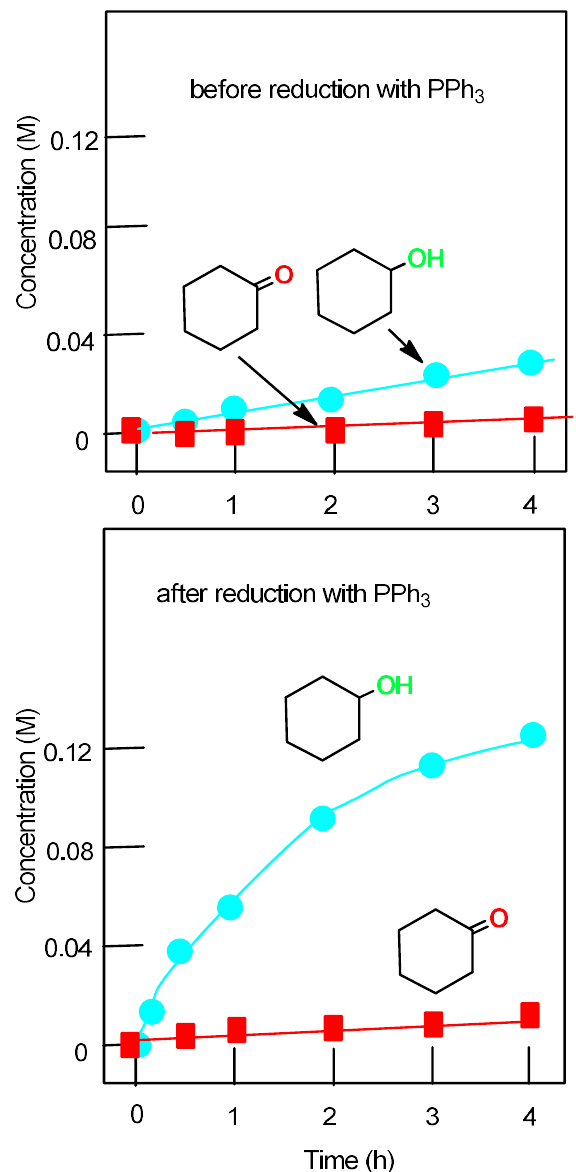
Figure 5. The accumulation of cyclohexanol and cyclohexanone in the oxidation of cyclohexane (0.46 M) with H 2 O 2 (2 M) catalyzed by complex 1 (5 × 10 −4 M), in the presence of HNO 3 (0.05 M) at 50 °C. In order to detect the formation of cyclohexyl hydroperoxide, the concentrations of the products were measured by GC before and after the reduction of the reaction sample with solid PPh 3 . In the absence of HNO 3 , the oxidation afforded only 0.015 M of products after 2 h (after the reduction of the reaction sample with solid PPh 3 ).